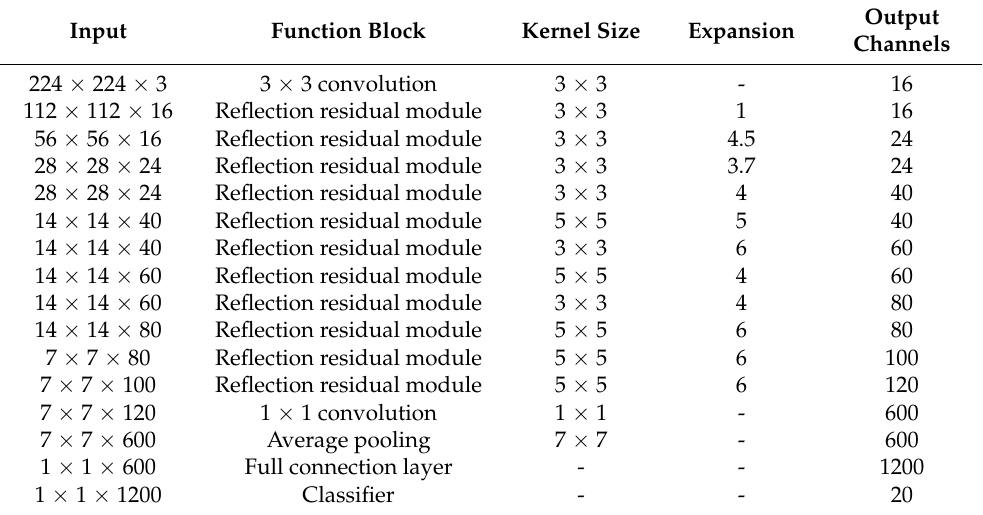
Table 1. The structure configuration of